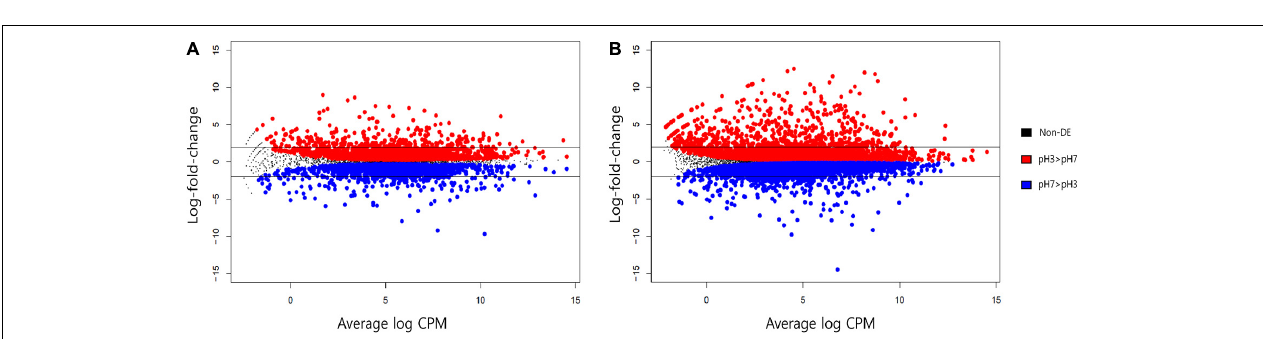
FIGURE 5 | Multidimensional scaling (MDS) plot of 15 RNA samples of Saccharomycopsis fibuligera . KPH12 strain (A) and KJJ81 interspecies hybrid strain (B) were grown at five different pH values for 18 h after inoculation, and total mRNA was prepared and sequenced. Dot colors : each dot color indicates the samples at the same pH point.